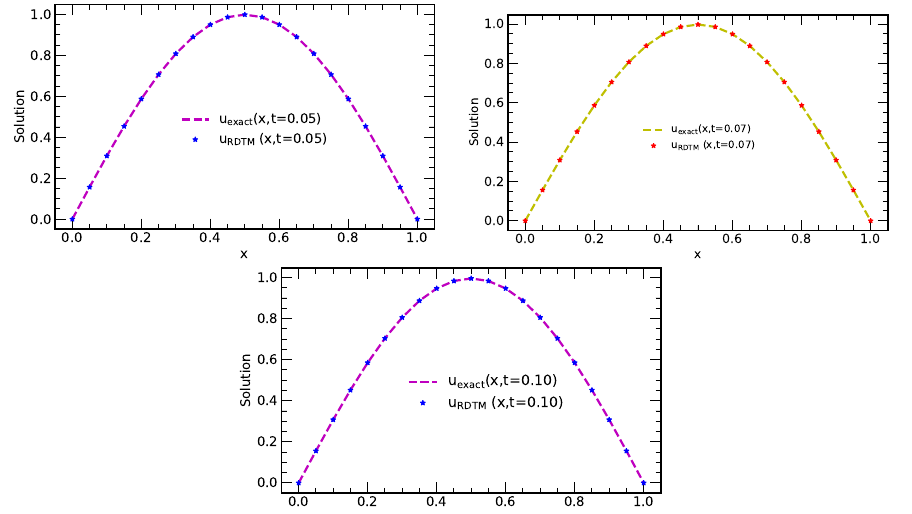
Figure 10. Plots of exact solution and approximate solution using RDTM at t = 0.05,0.07,0.10 (for numerical experiment 2).